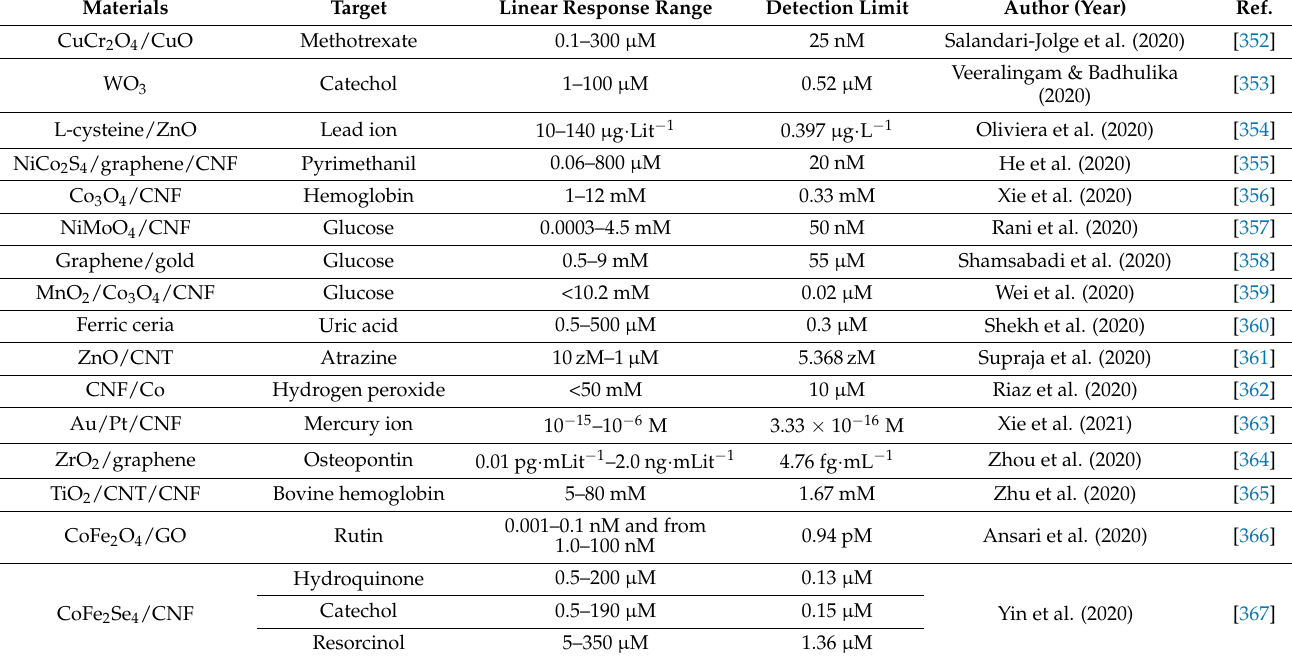
Table 9. Electrospun electrochemical sensors based on metals and metal